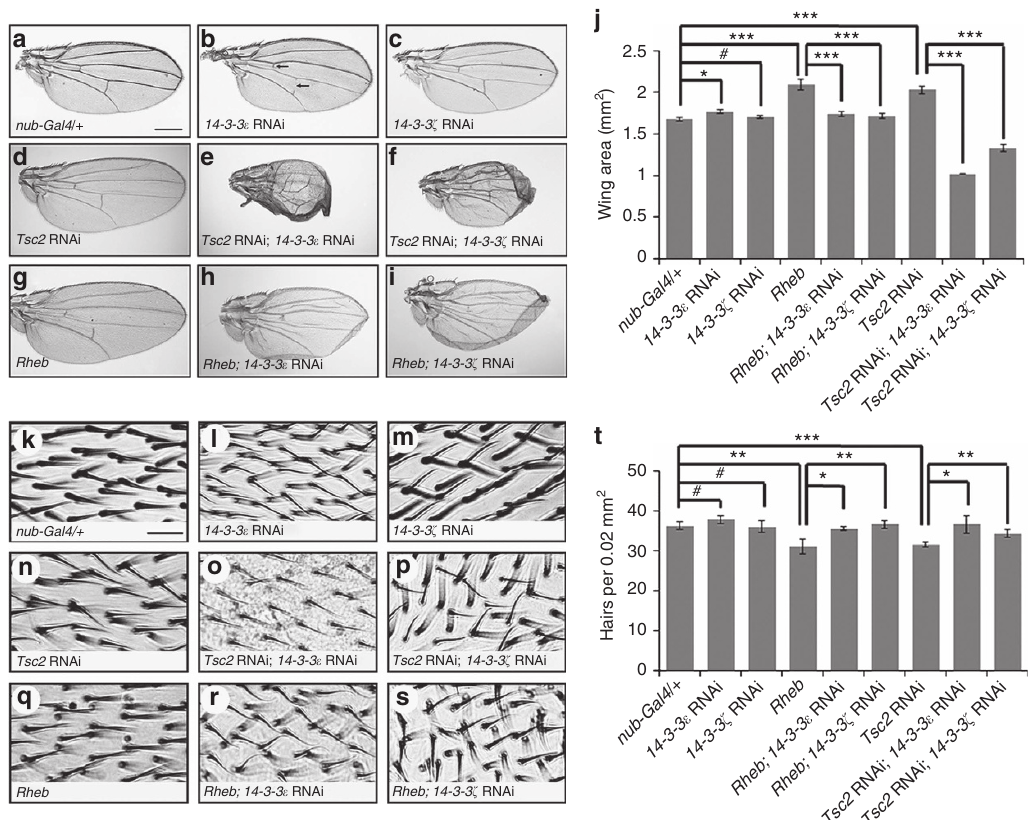
Figure 2 | Genetic interaction of 14-3-3 with Tsc2 and Rheb in the wing. ( a – f ) 14-3-3 shows genetic interaction with Tsc2 . ( a ) Control wing with one copy of nub-Gal4 is normal. ( b , c ) Knockdown of 14-3-3 e ( b ) or 14-3-3 z ( c ) does not affect wing size. ( d ) Tsc2 RNAi by nub-Gal4 causes enlarged wing. ( e , f ) Reduction of 14-3-3 levels in Tsc2 RNAi background results in inhibition of overgrowth and shape changes in wing. ( g – i ) Genetic interaction between Rheb and 14-3-3 in the wing. Overexpression of Rheb results in overgrowth of wing ( g ). ( h , i ) Knockdown of 14-3-3 e ( h ) or 14-3-3 z ( i ) suppresses the effects of Rheb overexpression. RNAi or overexpression was induced by nub-Gal4 ( a – i ). Scale bar, 400 m m ( a – i ). ( j ) Quantification of wing sizes shown in a – i . Knockdown of one isoform of 14-3-3 does not affect wing size compared with the control ( nub-Gal4/ þ ). Knockdown of Tsc2 or overexpression of Rheb increases the wing size about 20% compared with wild-type. Knockdown of one 14-3-3 isoform suppresses overgrowth phenotype caused by Rheb overexpression. Knockdown of one 14-3-3 isoform and Tsc2 results in about 30% reduction of wing size compared with the wild-type size. Error bars are s.d. n ¼ 10. * P o 0.01. *** P o 0.0001. # P 4 0.05 (t-test). ( k – s ) High magnification images of flat areas of adult wings with indicated genotypes. Scale bar, 15 m m. ( k ) Wild-type wing; ( l , m ) Knockdown of 14-3-3 e ( l ) or 14-3-3 z ( m ). ( n ) Knockdown of Tsc2; ( o , p ) Knockdown of both Tsc2 and 14-3-3 e ( o ) or 14-3- 3 z ( p ); ( q ) Overexpression of Rheb; ( r , s ) Overexpression of Rheb combined with knockdown of 14-3-3 e ( r ) or 14-3-3 z ( s ). ( t ) Quantification of hair numbers within the same area of wings (0.02mm 2 ). Knockdown of one isoform of 14-3-3 does not affect the hair number. Knockdown of Tsc2 or overexpression of Rheb causes about 20% reduction in the wing hair number compared with wild-type. Knockdown of one isoform of 14-3-3 combined with Tsc2 RNAi or Rheb overexpression results in similar wing hair numbers as wild-type. Error bars are s.d. n ¼ 10. * P o 0.01. ** P o 0.001. *** P o 0.0001. # P 4 0.05